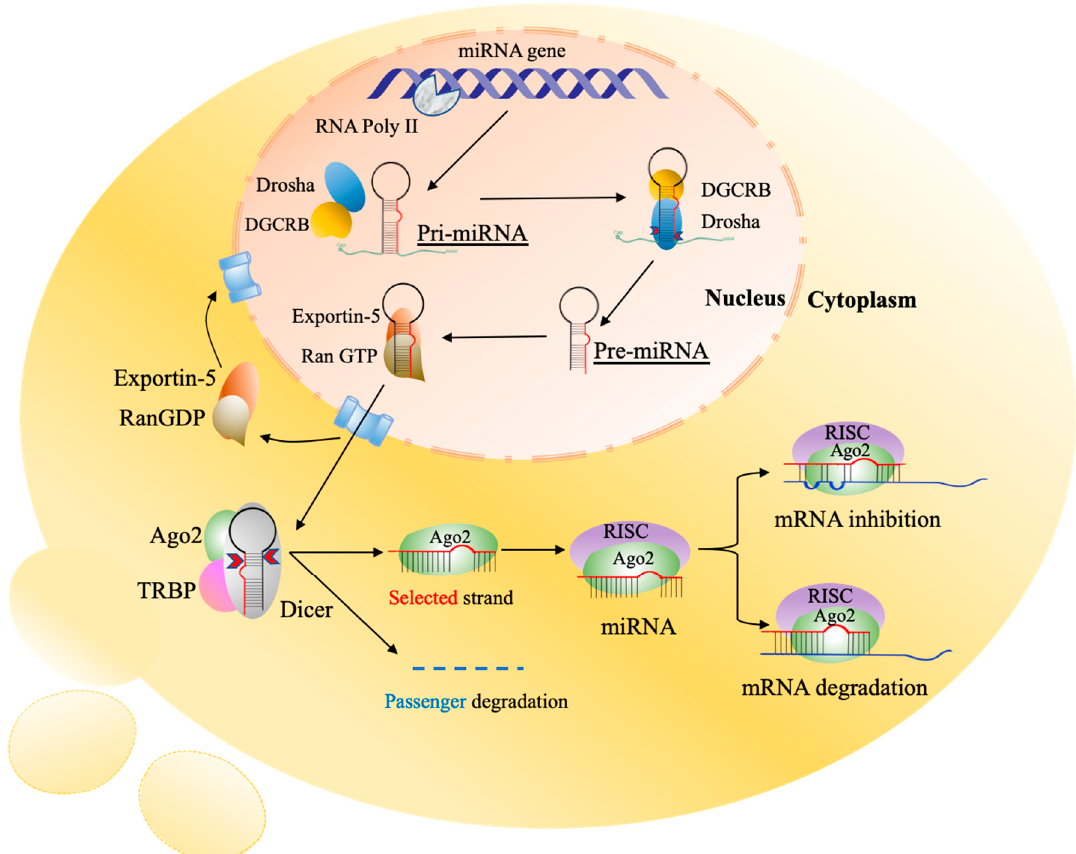
Figure 1. Biogenesis of miRNAs. The initiation process is started in the nucleus by RNA polymerase II which transcribes protein-coding genes into pri-miRNAs with a large cap and polyadenylation. The pri-miRNAs are processed by a complex of Drosha and RNA-binding protein DGCR8 to produce the stem-looped structures of 59–89 nucleotides (nt) known as pre-miRNAs. Then, pre-miRNAs are transported into the cytoplasm by exportin-5/Ran-GTP, and further processing occurs to generate mature miRNAs where Dicer cleaves stem-looped structures into double-strand miRNAs. One functional miRNA strand (red) is loaded with Ago2 into the RISC, and that complex, miRISC, binds to the complementary sequences of target mRNA in the 3 ′ UTR. The result of these interactions is degradation and suppression of translation of the specific mRNA. pri-miRNAs, primary miRNAs; pre-miRNAs, processor miRNA; Dicer, RNase III nuclease; RISC, RNA-induced silencing complex; Ago2, and Argonaute 2. The image is adapted from Strubberg and Madison [18].